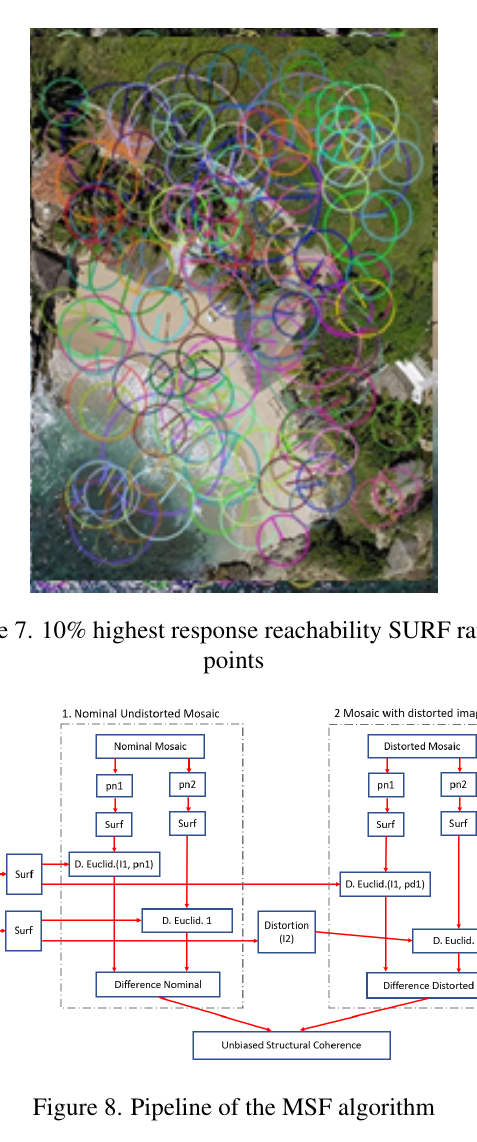
Figure 8. Pipeline of the MSF